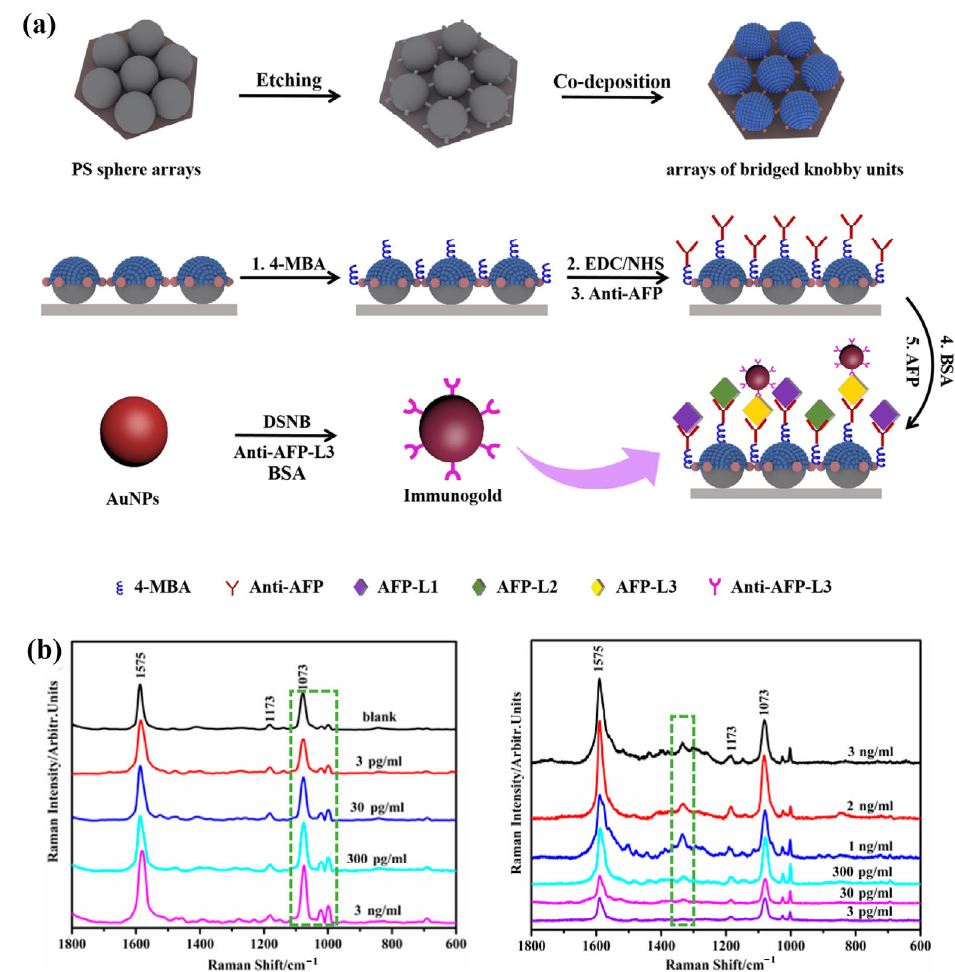
Figure 8. Fabricating process and SERS spectra of plasmonic structure for tumor marker detection. ( a ) The fabrication process of the bridged knobby units. ( b ) The SERS spectrum of α -fetoprotein (AFP) and α -fetoprotein-L3 (AFP-L3) in different concentrations in the biosensor. Reproduced with permission from reference [70]. Copyright 2020 Elsevier B.V.